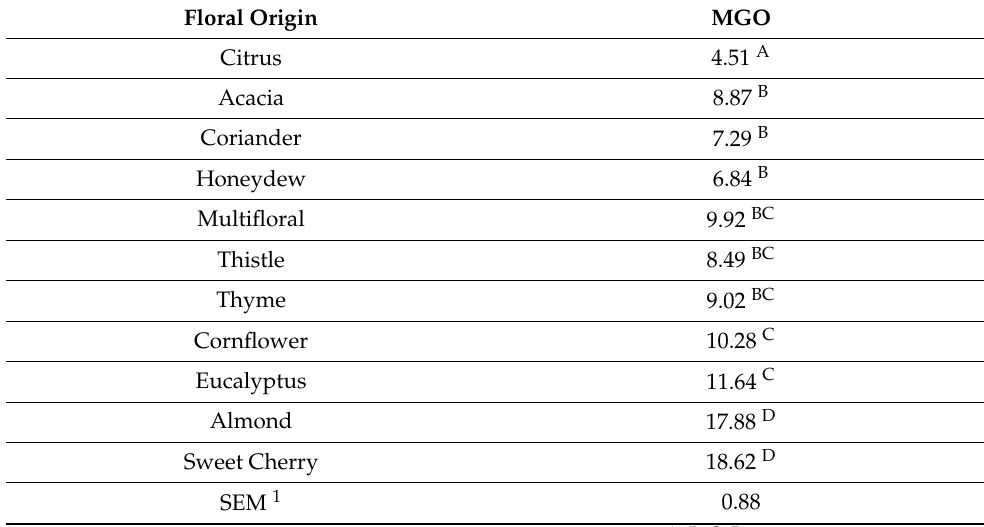
Table 4. MGO data statistical